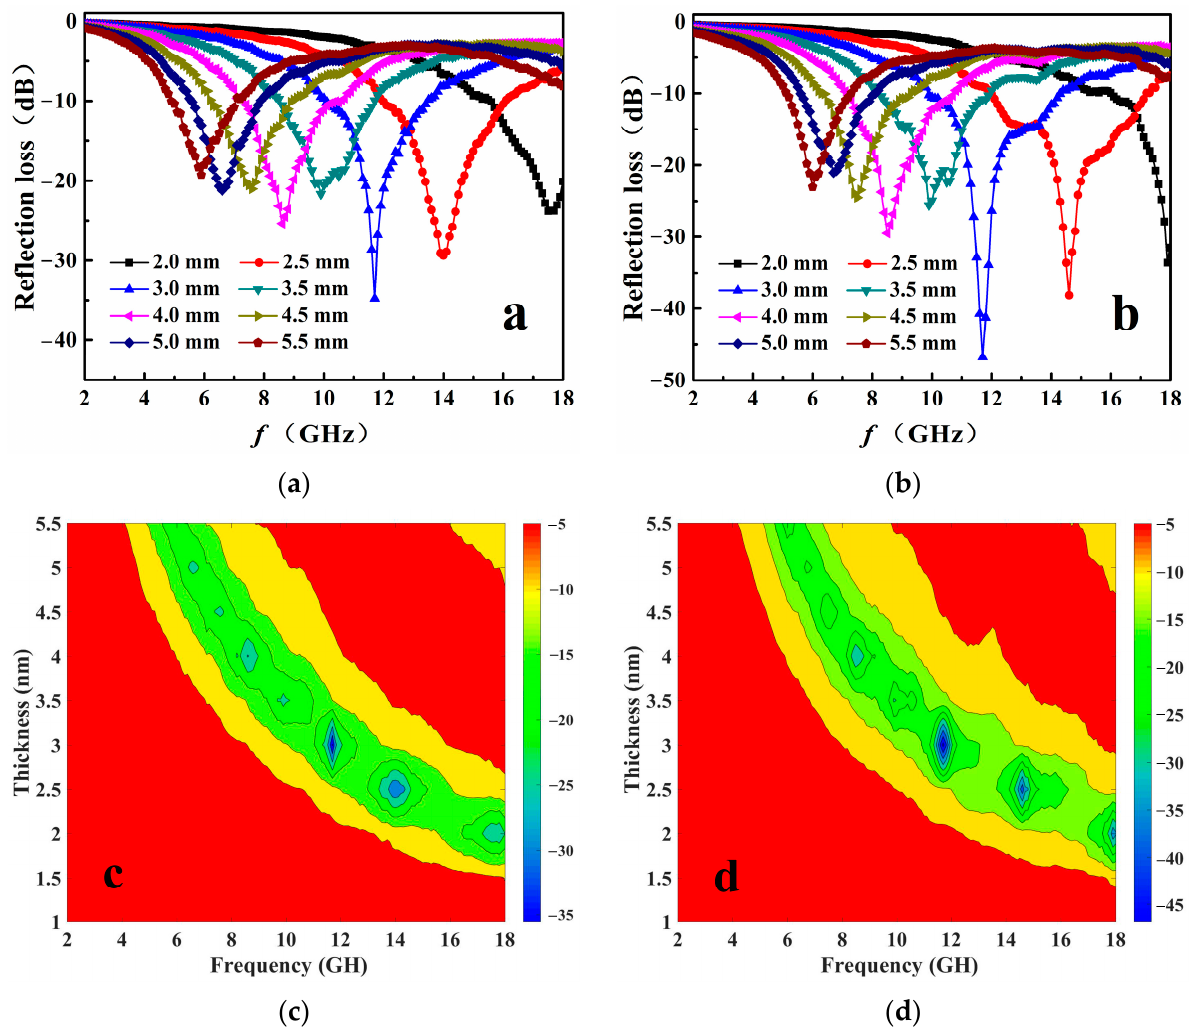
Figure 7. The reflection loss ( R L ) of 3D-GLN ( a ) and 3D-GLN/Fe 3 O 4 ( b ) with different thicknesses. The R L contour maps with different thickness and frequency of 3D-GLN ( c ) and 3D-GLN/Fe 3 O 4 ( d ). Table 1. Microwave-absorption performances of similar absorbing materials reported